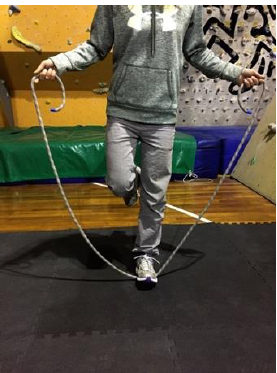
Figure 5. Flex foot and rope locked by the foot.